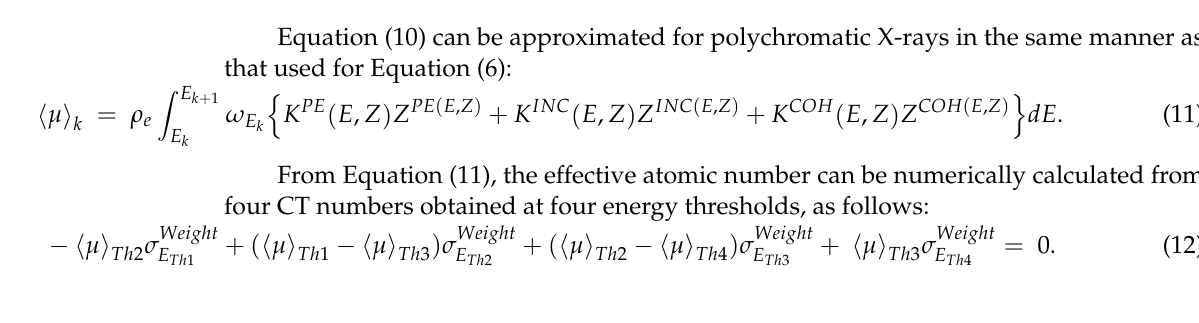
Figure 2. ( a ) µ ( E , Z ) / ρ e (solid line) from 30 keV to 150 keV of atomic numbers up to 29, calculated via three-PFM using Equation (10), and corresponding NIST values (marker), ( b ) relative errors between calculated and NIST values in ( a ).